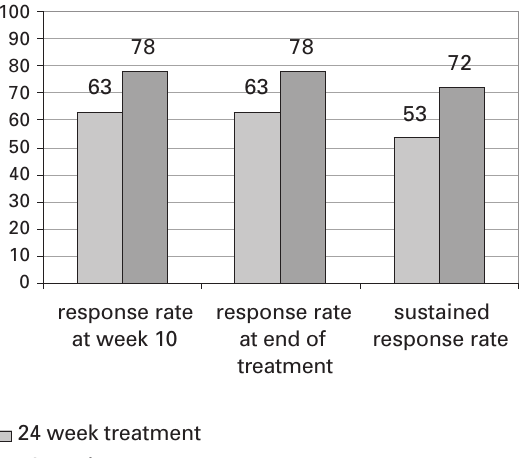
Rates of sustained response (SR) to treatment according to baseline character- istics (statistics were not performed due to small